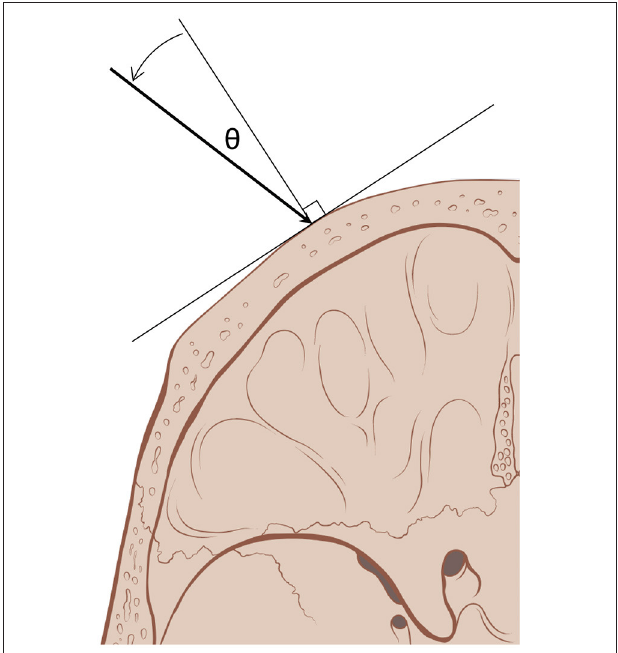
FIGURE 1 | Incident angle ( θ ) measures the degree from normal, orthogonal, at which acoustic beams (arrow) emitted by ultrasound elements reach the outer table of the skull. With a smaller incident angle, a greater proportion of the beam’s energy traverses the skull (skull art reused with permission from Patrick J. Lynch and C. Carl Jaffe,